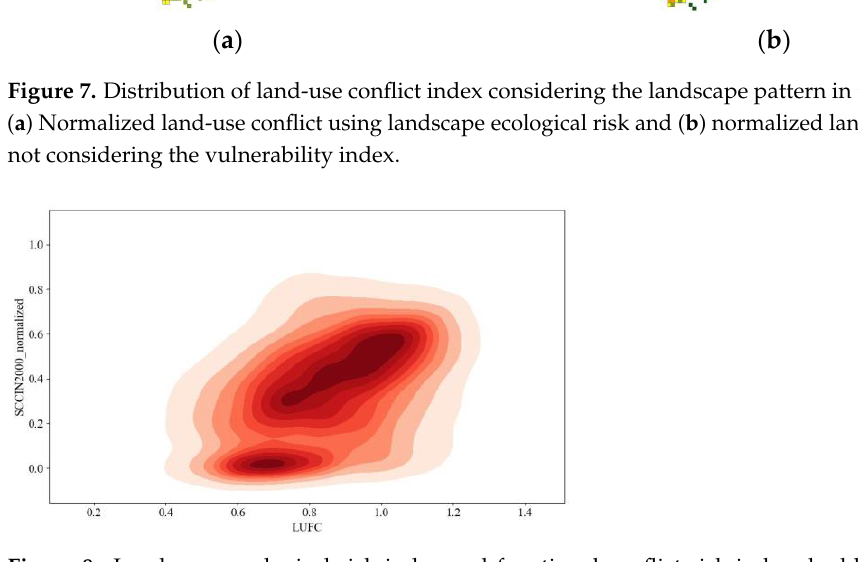
Figure 9. Types of landscape complexity conflicts for units of high or low functional suitability con- flict, with typical sites of ( a ) low LUFC and low landscape complexity conflicts, ( b ) low LUFC and high landscape complexity conflicts, ( c ) high LUFC and low landscape complexity conflicts with ecological aspects dominating, ( d ) high LUFC and high landscape complexity conflicts, ( e ) high LUFC and low landscape complexity conflicts with production aspects dominating. 3.2. LUCC Pattern and Its Relationship with Land-Use Conflicts 3.2.1. Land-Use/Cover Change in the Research Area During 2000–2010 and 2010–2020, cultivated land, especially paddy fields, decreased by the most, transforming into urban–rural construction land, but this has eased in the last 10 years. Another land use transformation worth noticing is the transformation of dry land into sparse forest land and shrub forest land (with a total amount of 81.3 km 2 ), which went through little change during 2010–2020 (Figure 10a). Thanks to the transformation of paddy fields into dry land, and land consolidation projects that restore the shrubbery to dry land, the full scale of dry land remained unchanged from 2010 to 2020 (Figure 10b). The different patterns of land use transformation among the “ecology, production and living” space in the different regions of the “Western Protected Area” are shown. From the perspective of net flow from 2000 to 2020 (Table 4), the net flow of paddy fields to construction land was 318 km 2 , and 18.9 km 2 to forest land, the net flow of dry land to construction land was 7.7 km 2 and 50.1 km 2 to forest land, which represented two types of multi-functional conflict, the “production–living conflict” and “production–ecology conflict”.